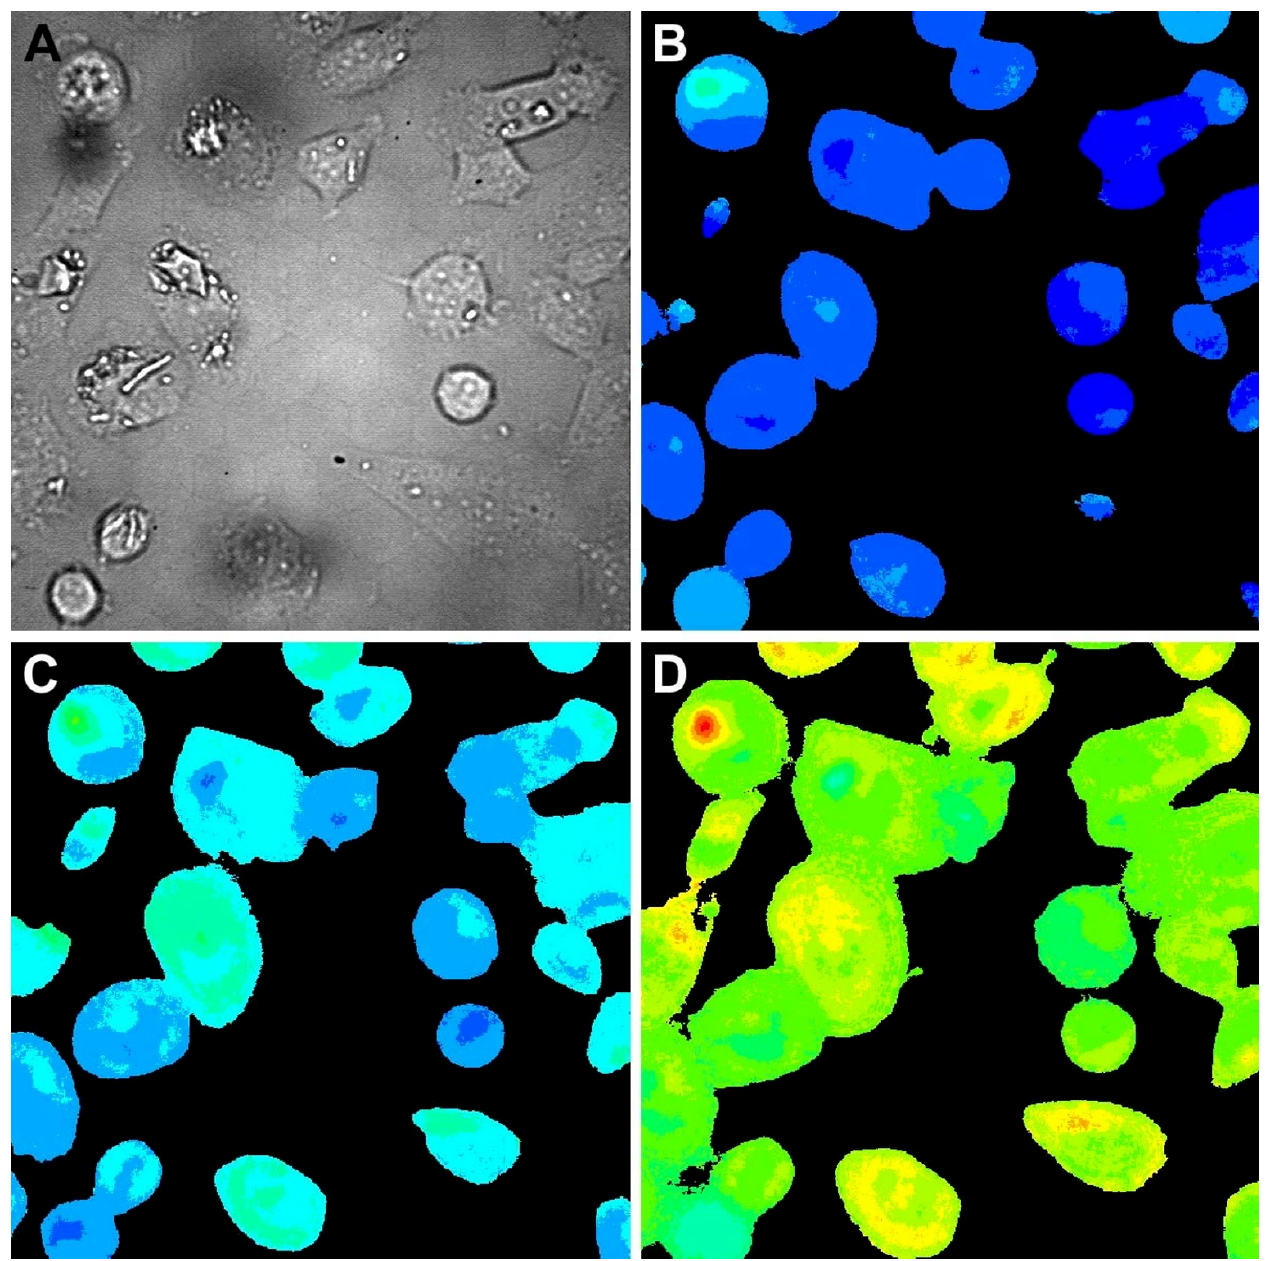
Effect of ethylene gas on [Ca 2+ ] level in SaOS-2 cells kept under pressure. Cells grown on coverslip were loaded i with Fura-2 and transferred into a pressure chamber as described in Materials and Methods. A. Cells inspected by Nomarski phase contrast interference optics. B. Untreated cells. C. Cells kept under pressure (1 atm) for 10 min. D. Cells kept under pressure (1 atm) 10 min after ethylene gas injection into the pressure chamber. Magnification, 200-fold. For further details, see Figure